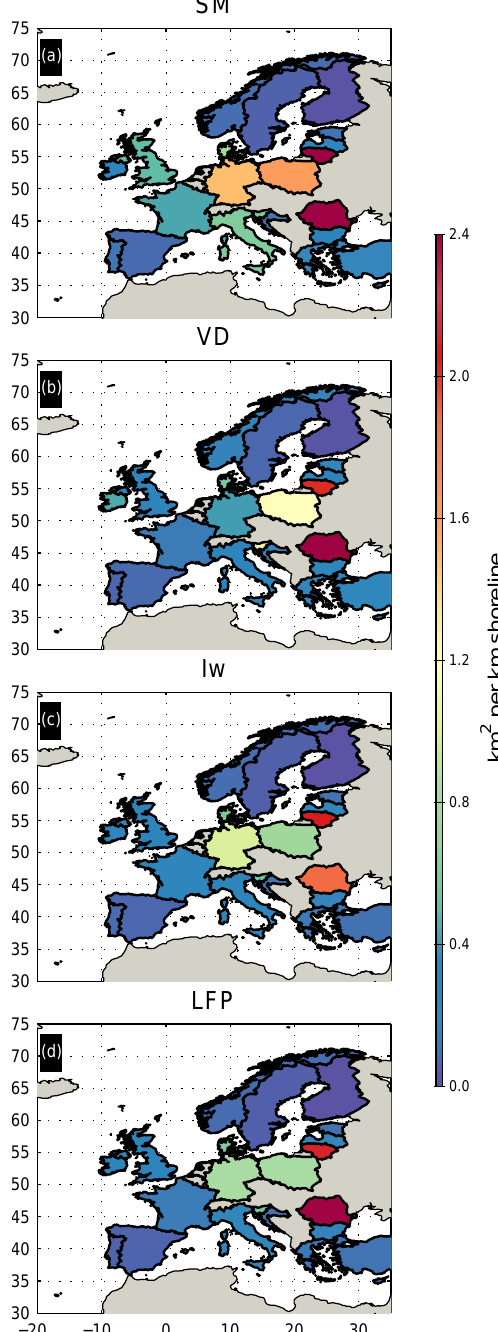
Figure 6. Estimated coastal flood extent for the present-day 100-year event using all four approaches, aggregated per country level, and normalized by coastline length. Values correspond to km 2 per km of